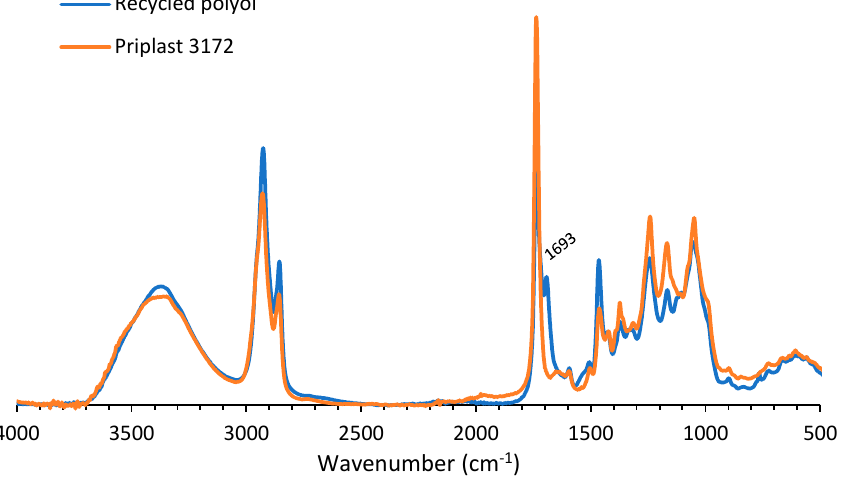
Figure 6. IR spectrum of recycled polyol and Priplast 3172.